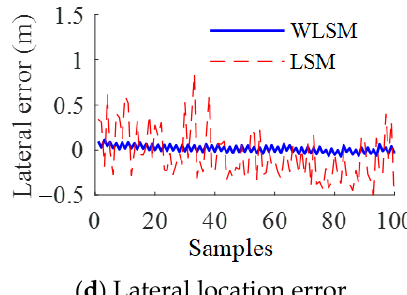
Figure 9 . Location results under condition ( b ).